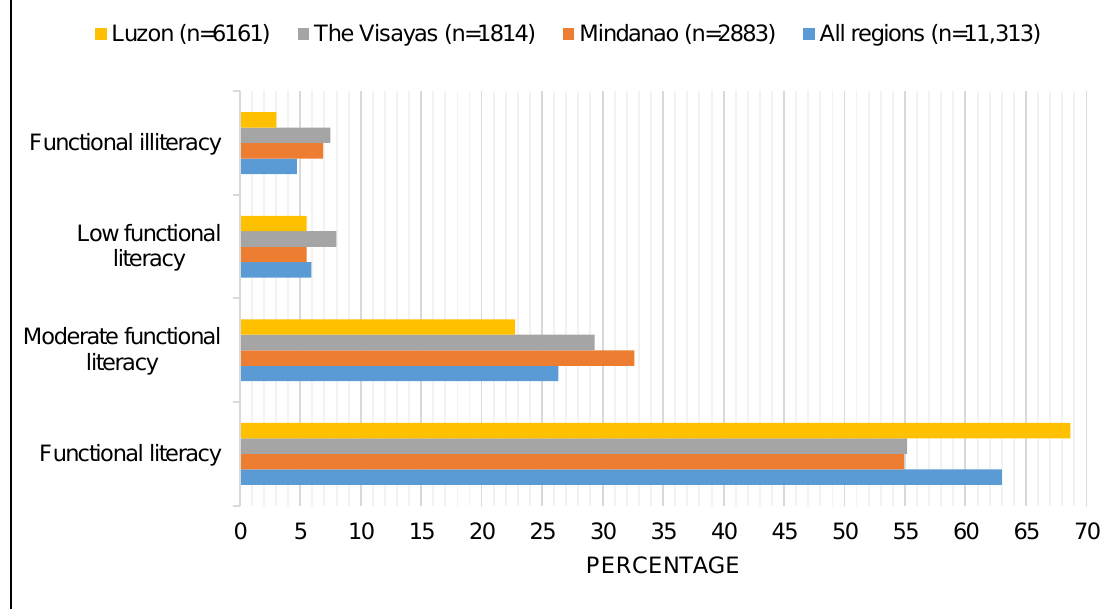
Figure 2. Prevalence of functional literacy in school-aged children in three regions of the Philippines.